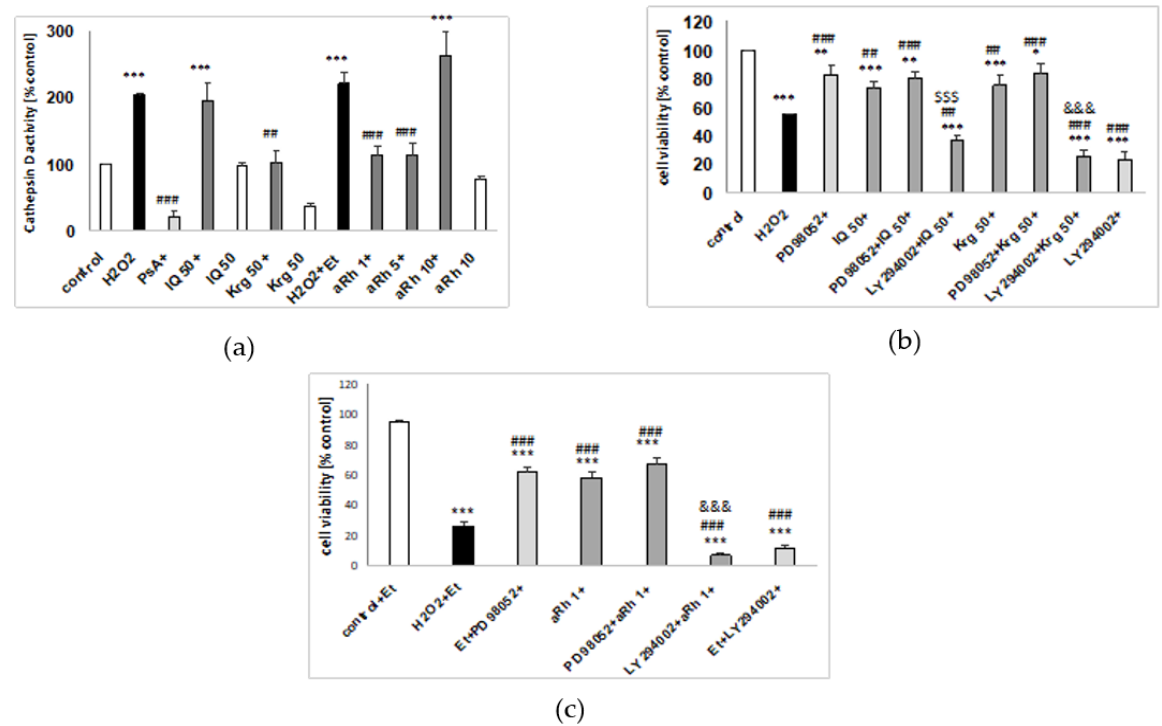
Figure 7. Involvement of cathepsin D, MAPK/ERK1/2 and PI3-K/Akt pathways in neuroprotective action of flavonols: ( a ) The effects of the tested flavonols against hydrogen peroxide (H 2 O 2 )-induced cathepsin D activity in UN-SH-SY5Y cells. The cells were pre-treated for 30 min with isoquercitrin (IQ, 50 µM), kaempferitrin (Krg, 50 µM) and α-rhamnoisorobin (aRh, 1–10 µM) followed by 18 h exposure to H 2 O 2 (0.375 mM). Cathepsin D inhibitor pepstatin A (PsA, 0.3 µM) was used as a positive control for the assay. ( b , c ) The effects of MAPK/ERK1/2 and PI3-K/Akt inhibitors on the flavonol-mediated protection against H 2 O 2 -evoked cell damage. The UN-SH-SY5Y cells were pre-treated for 30 min with the MAPK/ERK1/2 inhibitor PD98052 (10 µM) or the PI3-K/Akt inhibitor LY294002 (10 µM) followed by the next 30 min treatment with IQ (50 µM), Krg (50 µM) or aRh (1 µM) and subsequent exposure to H 2 O 2 (0.375 mM) for the next 24 h. The data were normalized to the vehicle-treated cells and are presented as the mean ± SEM. The data were analyzed by one-way ANOVA. * p < 0.05, ** p < 0.01, *** p < 0.001 vs. the vehicle-treated cells; ## p < 0.01 and ### p < 0.001 vs. the H 2 O 2 -treated cells; &&& p < 0.001 vs. H 2 O 2 + Krg/aRh; $$$ p < 0.001 vs. H 2 O 2 + IQ.